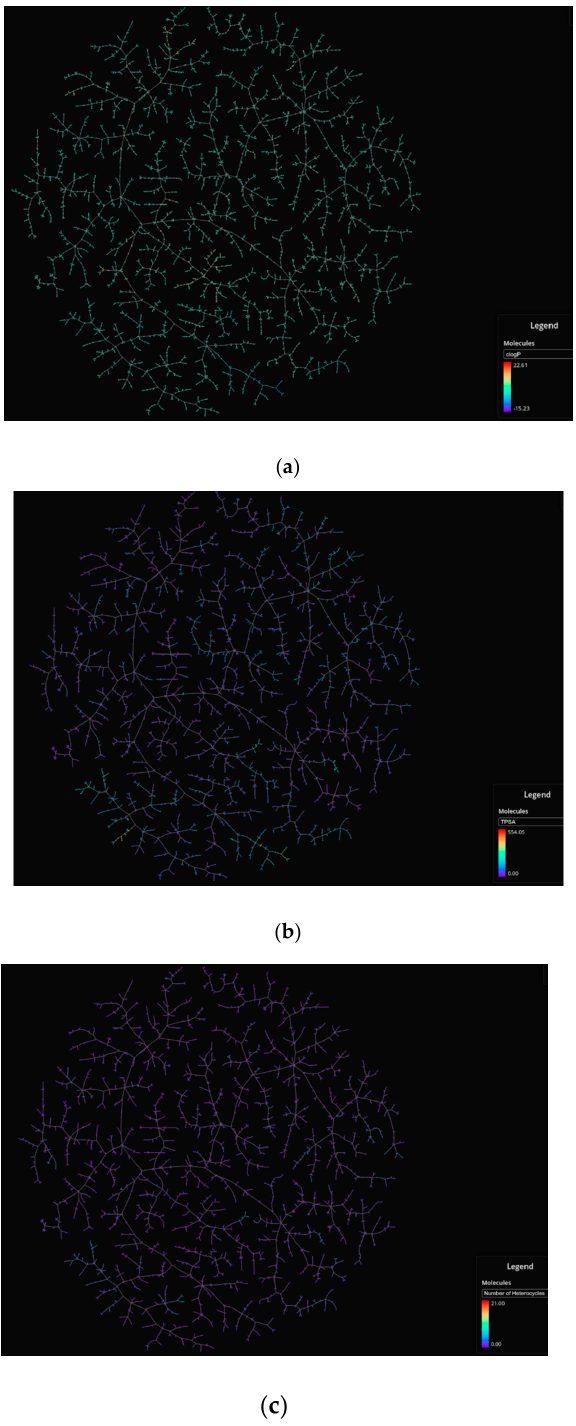
Figure 6. t-Maps for binders and nonbinders in the evaluation set. ( a ) clog P ; ( b ) TPSA (Å 2 ); ( c ) Number of heterocycles.